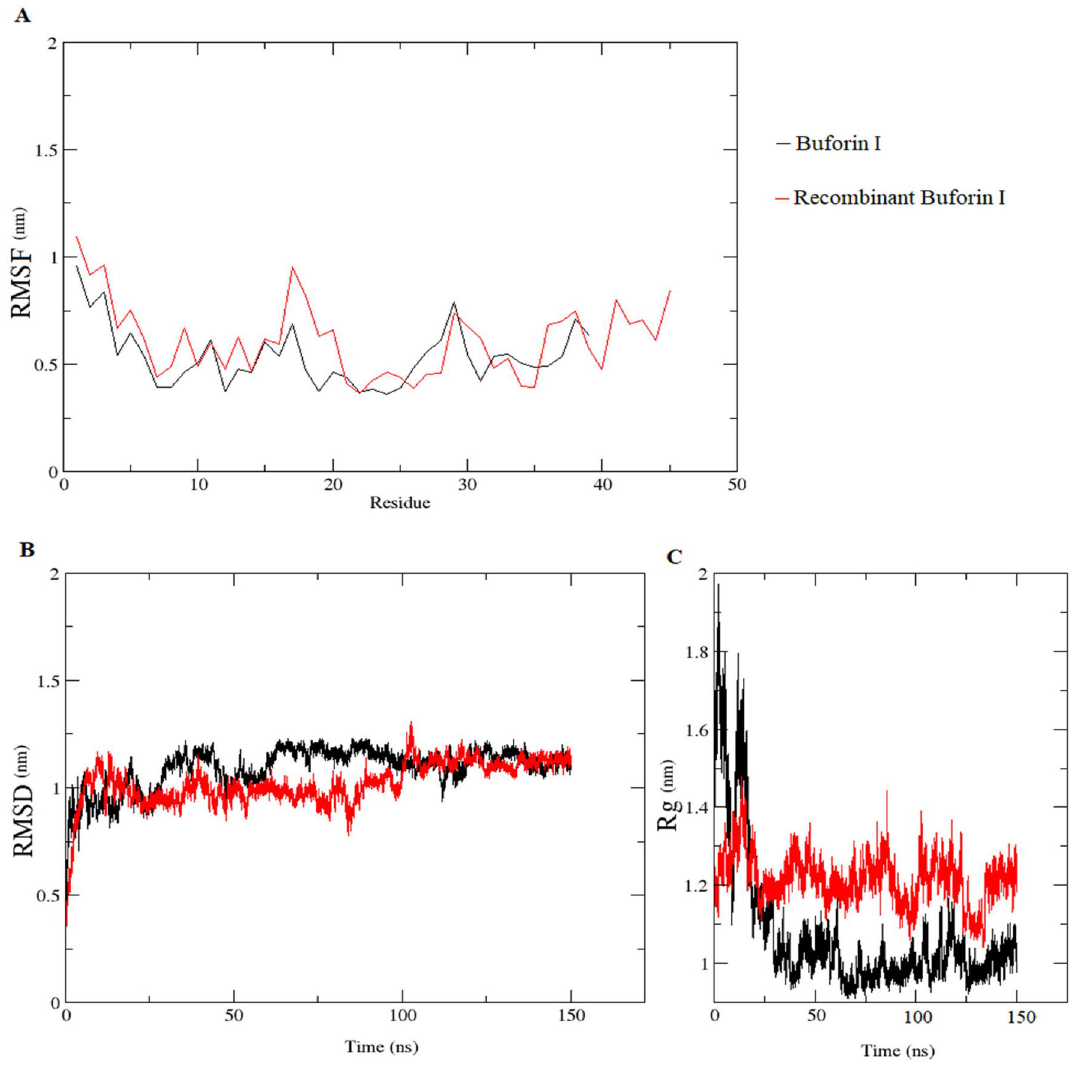
Figure 9. In silico assessment of stability of buforin I and recombinant buforin I at 310 °K. ( A ) RMSF, ( B ) RMSD, and ( C ) Radius